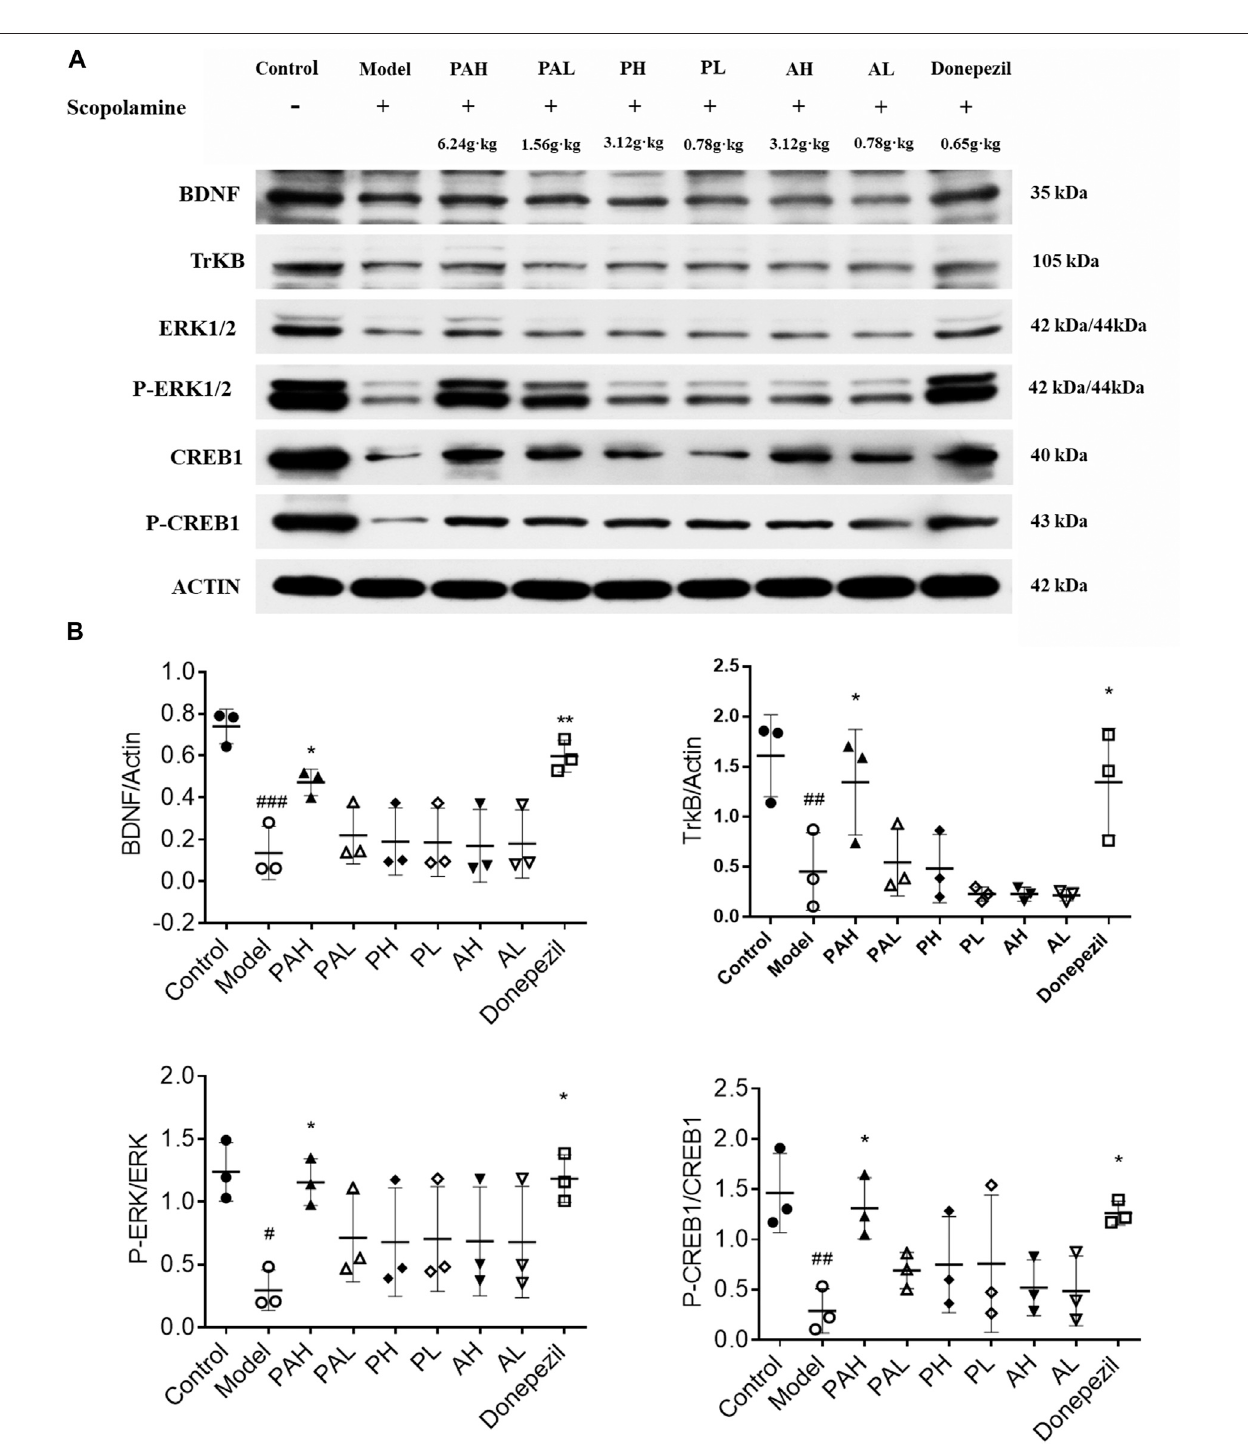
FIGURE 6 | Effect of PA on synaptic protein expression levels in scopolamine-treated mice. Data represent mean ± S.D. ( n (cid:1) 3). # p < 0.05, ## p < 0.01 and ### p < 0.001 vs control mice; * p < 0.05 and ** p < 0.01 vs scopolamine-treated mice.